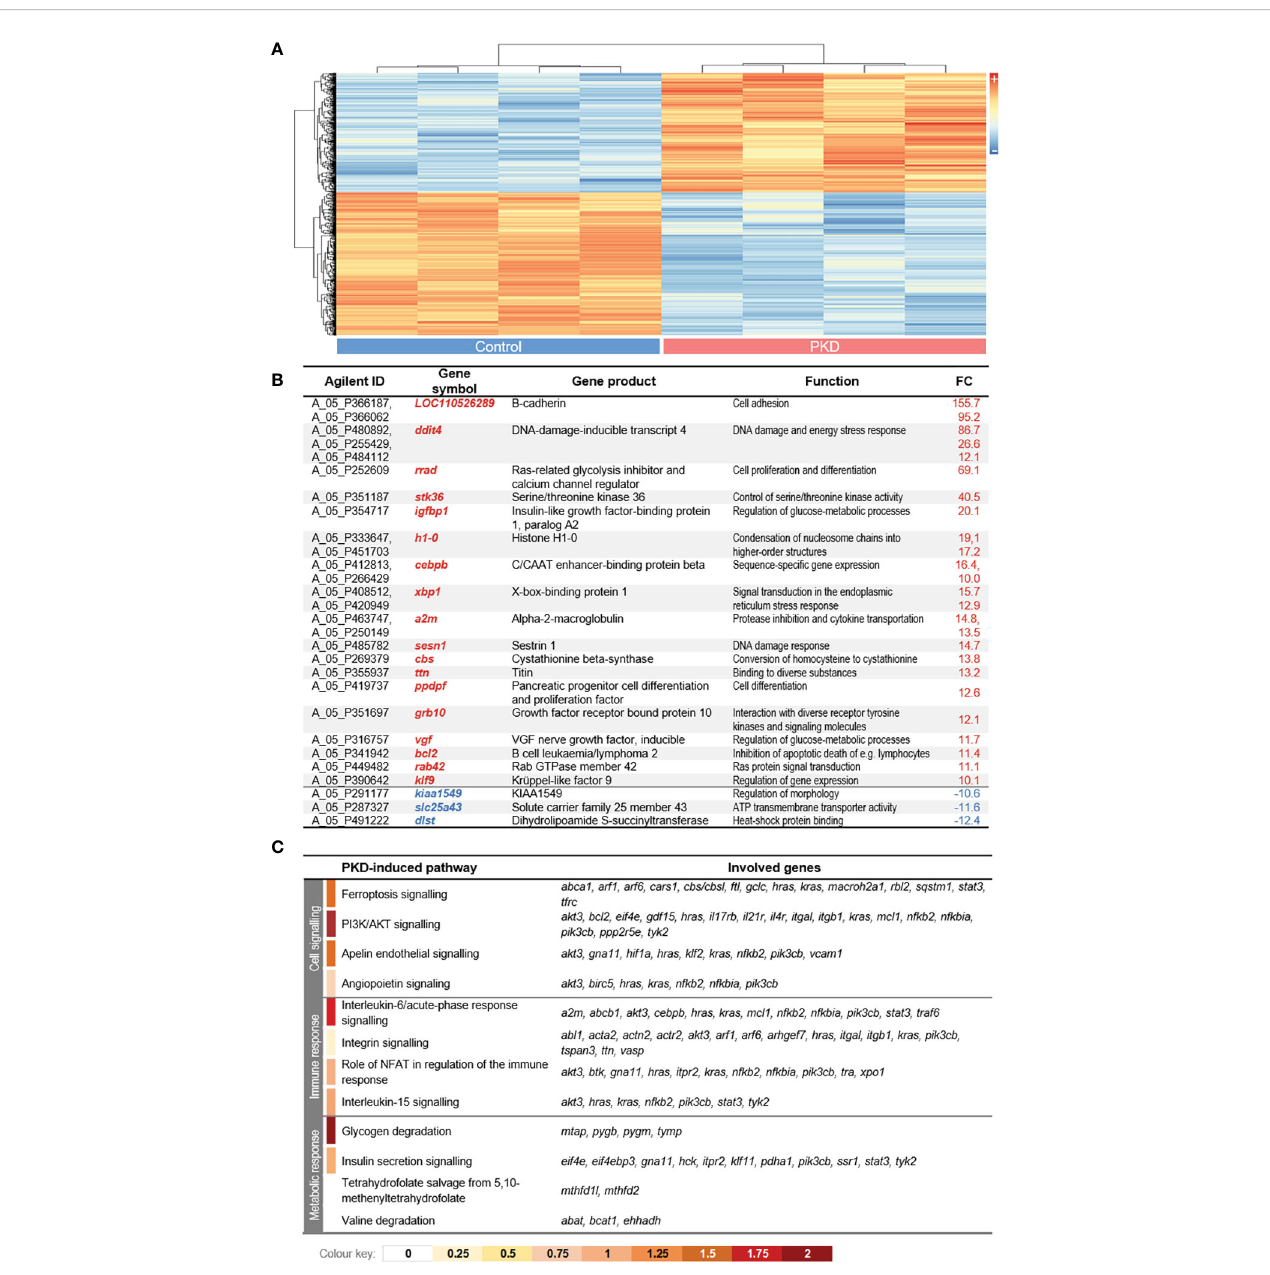
FIGURE 5 (A) Hierarchical clustering dendrogram of signi fi cantly differentially expressed (DE) genes (with |log2 FC|> 2; q < 0.01) from the comparison of control (left panel) versus red blood cells (RBCs) from fi sh with proliferative kidney disorder (PKD) (right panel). Samples from the infected group represent RBCs with between 91.5% to 95.3% positive mAb 1.14 staining as determined using gates and criteria that are shown in Supplementary Figure 7 (examples of how we determined the percentage of mAb 1.14-positive cells). High and low expression intensities are represented by red and blue colors, respectively (see scale on the left margin). (B) List of DE genes with an absolute fold-change value >10 (excluding uncharacterized LOCs). Genes are listed as gene symbols along with the corresponding gene product and function. (C) List of the top four signi fi cantly enriched canonical pathways (with z ≥ 0) in control and PKD groups. The color code below the table displays the z-score